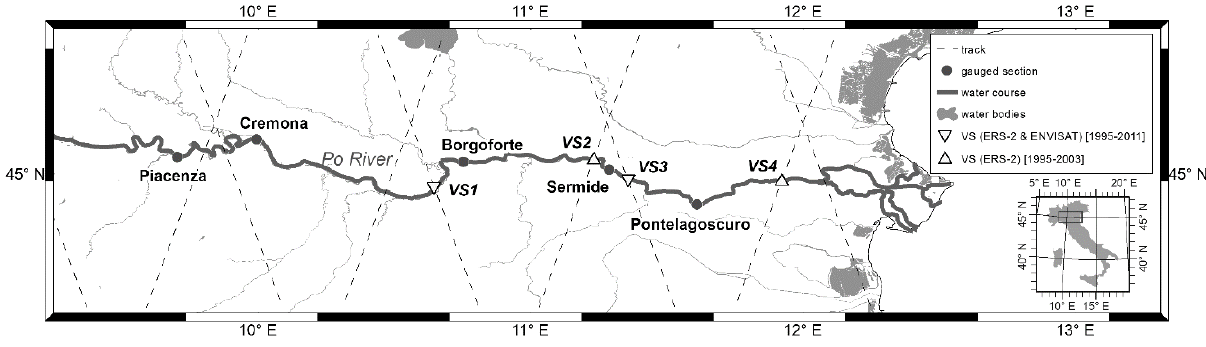
Figure 1. Geographical location of the study area. Spatial distribution of in situ and virtual stations used in the study. Diagonal tracks correspond to ERS-2 and ENVISAT satellite overpasses.